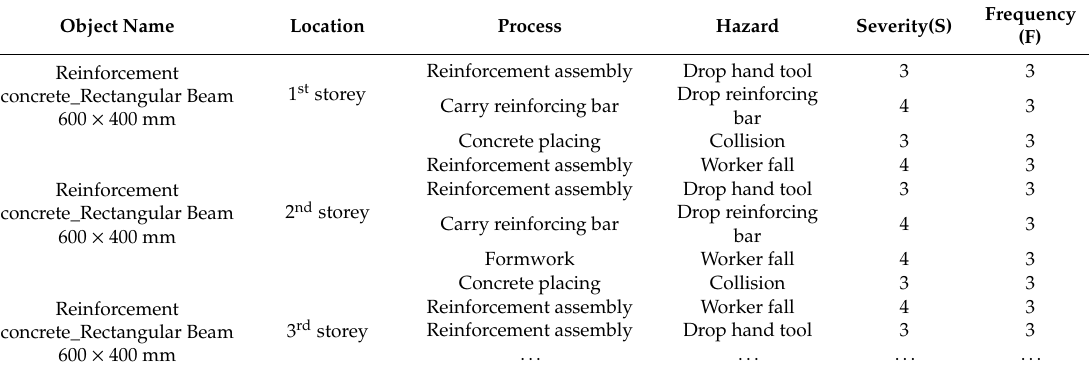
Table 6. Results of BIM model based risk assessment (focusing on beam